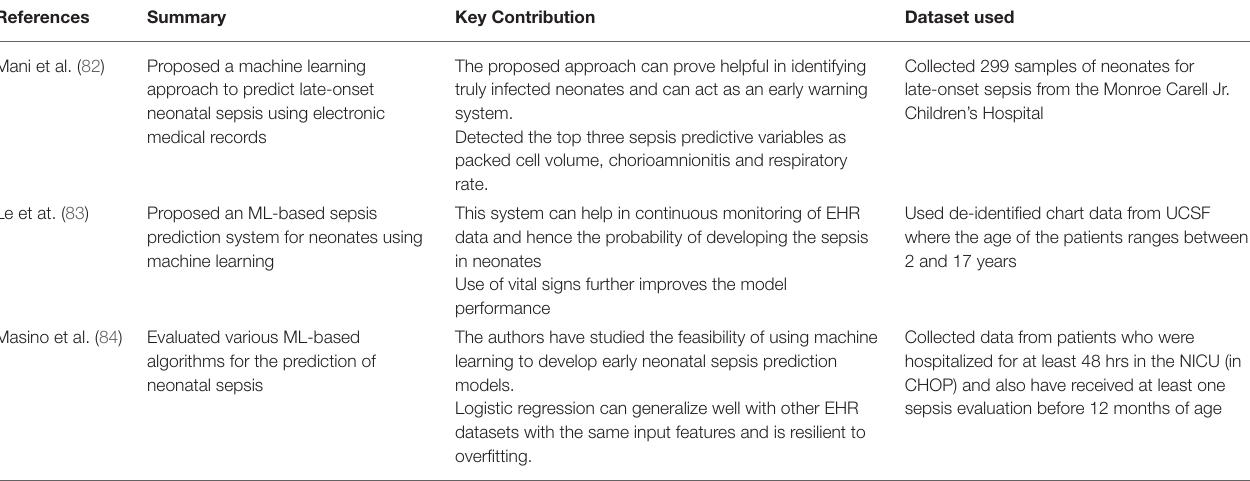
TABLE 9 | Summary of approaches used to predict neonatal sepsis.